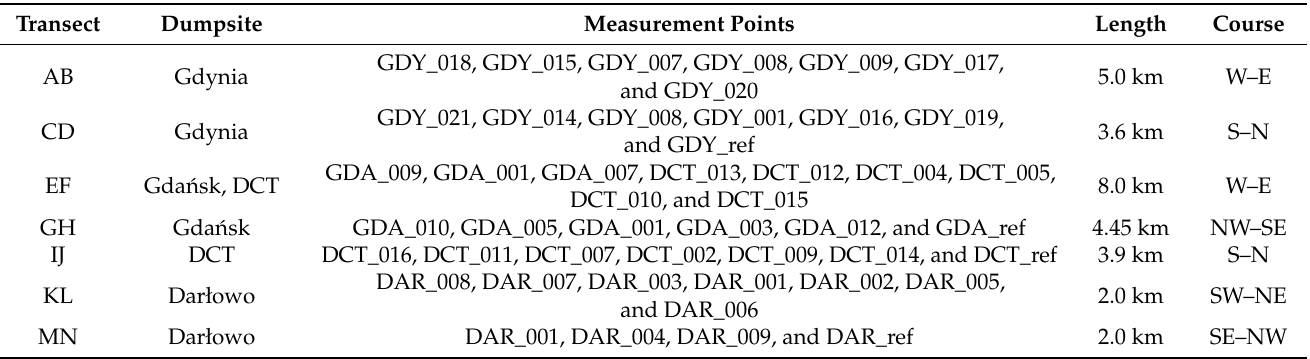
Table 1. Transects with the name of the place of measurement, the length, and the